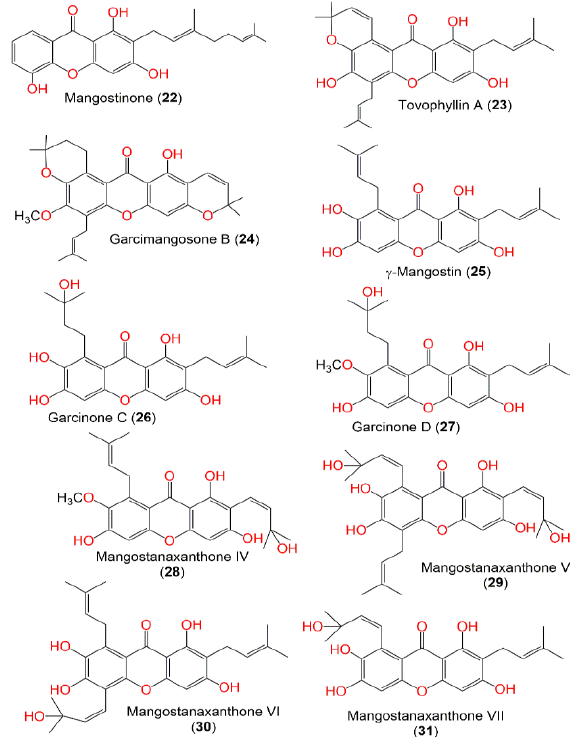
Figure 3. Structures of compounds 22 – 31 .